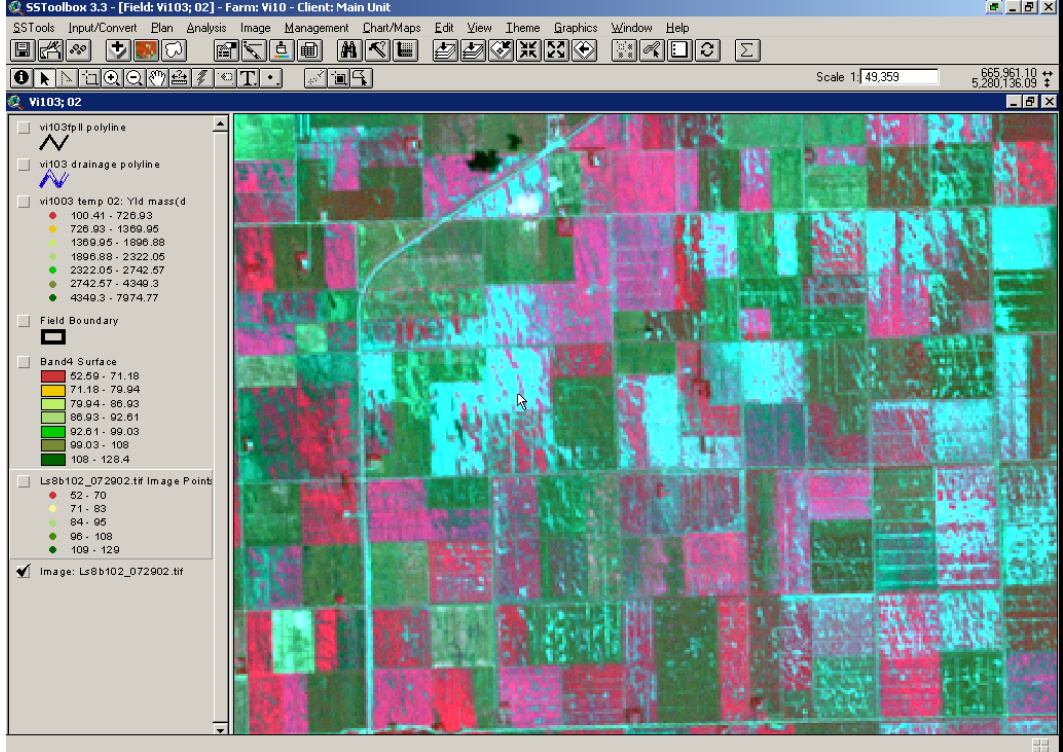
Figure 7. Waterlogged fields shown in light blue in this Landsat TM standard false color composite image (bands 4, 3, and 2) downloaded from DNGP by a